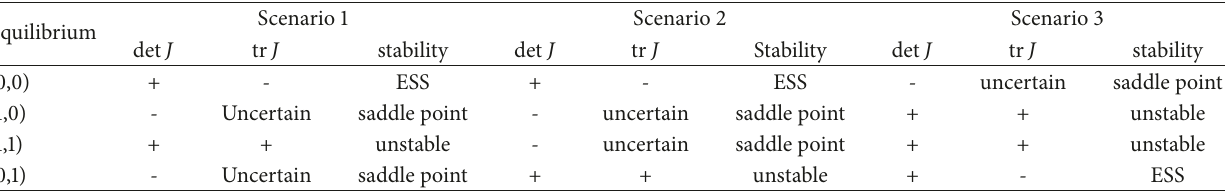
Table 4: Equilibrium point local stability (Scenarios 1, 2, and